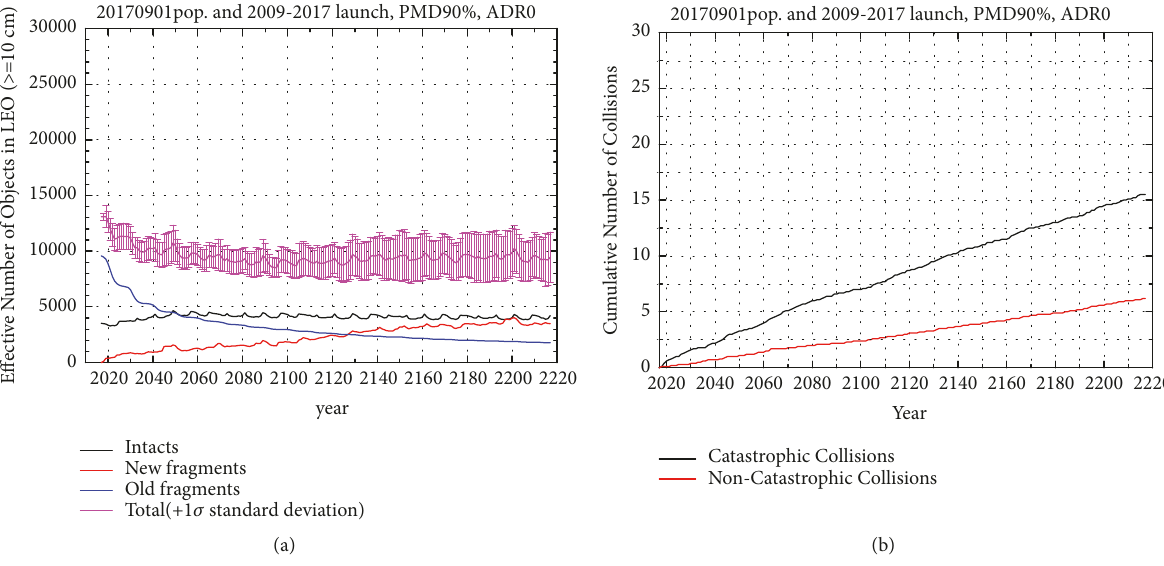
Figure 12: The evolution results of scenario 3, with PMD rate of 90%. (a) The population evolution. The line of total is plotted with the error bar of 1 𝜎 standard deviation. (b) The cumulative number of